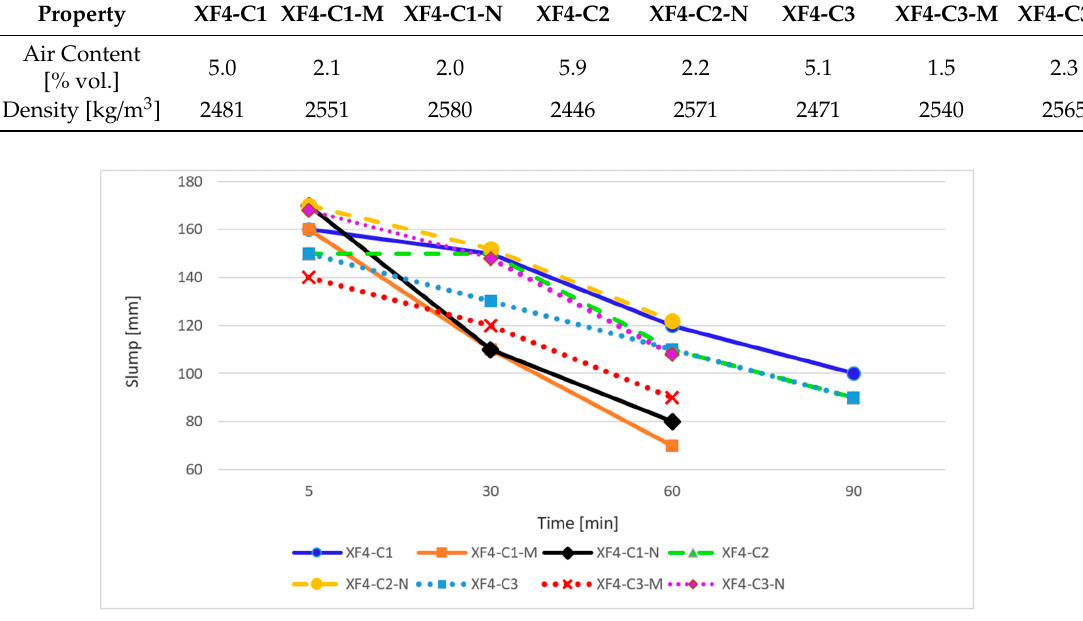
Figure 8. Consistency of concrete mixtures XF4 in time.